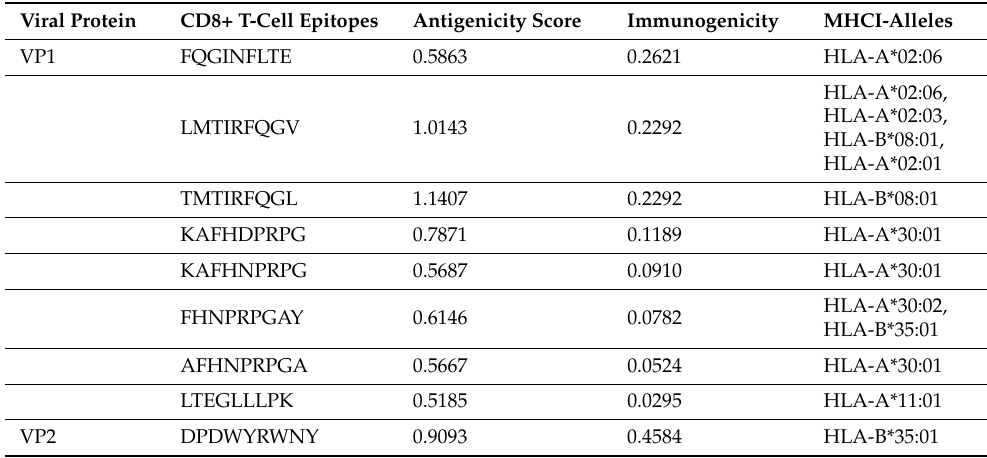
Table 1. The list of selected CD8 + T-cells epitopes of VP1 and VP2 interacting with MHC class I HLA-alleles. Viral Protein CD8+ T-Cell